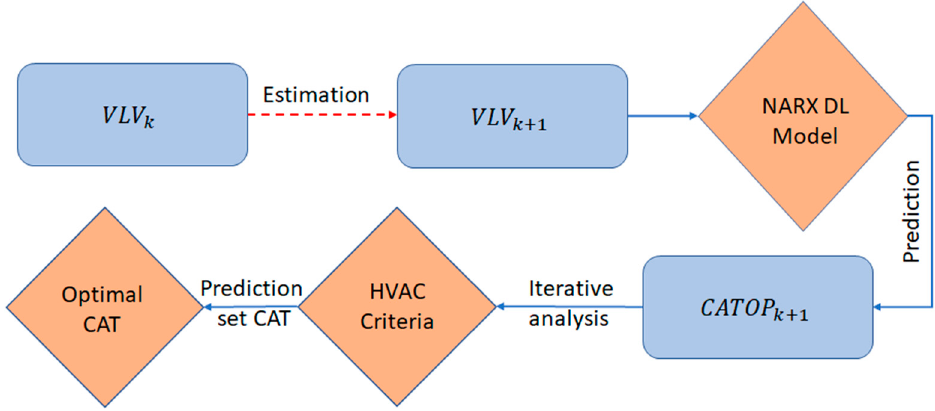
Figure 4. Prediction of CAT—Process [13].